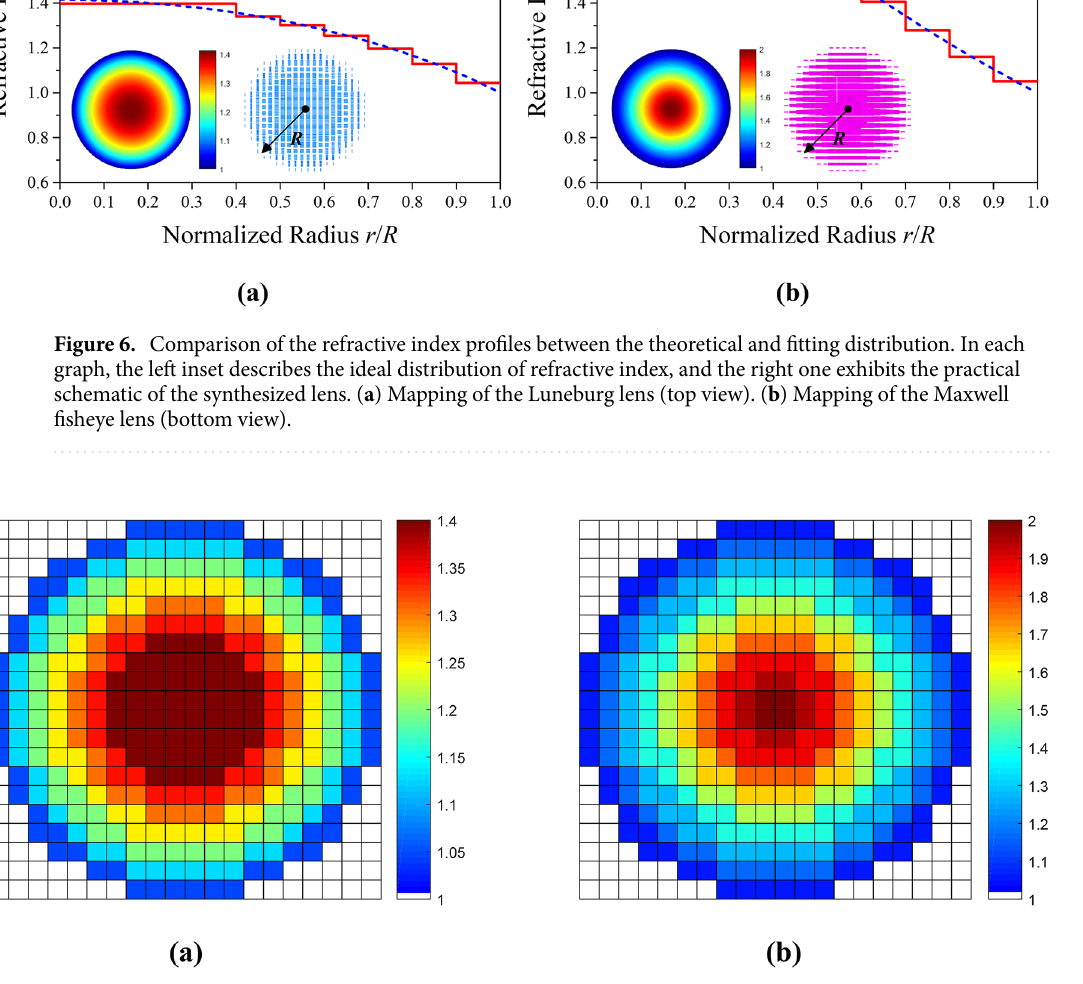
Figure 7. Discretized distribution of the refractive index. ( a ) Mapping of the Luneburg lens. ( b ) Mapping of the Maxwell fisheye